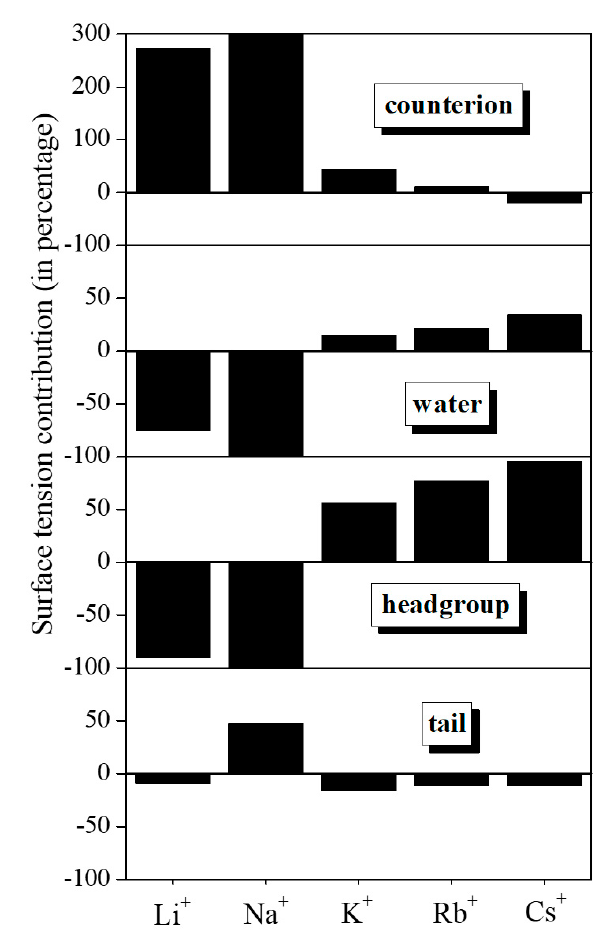
Figure 5. Surface tension contributions (in percentage) of the counterions (top panel), water molecules (second panel), as well as the DS − headgroups (third panel) and tails (bottom panel), as obtained from our simulations with different alkali counterions. Table 2. Contribution of the different molecules and moieties to the surface tension in the five alkali dodecyl sulfate solutions simulated (in mN/m units).